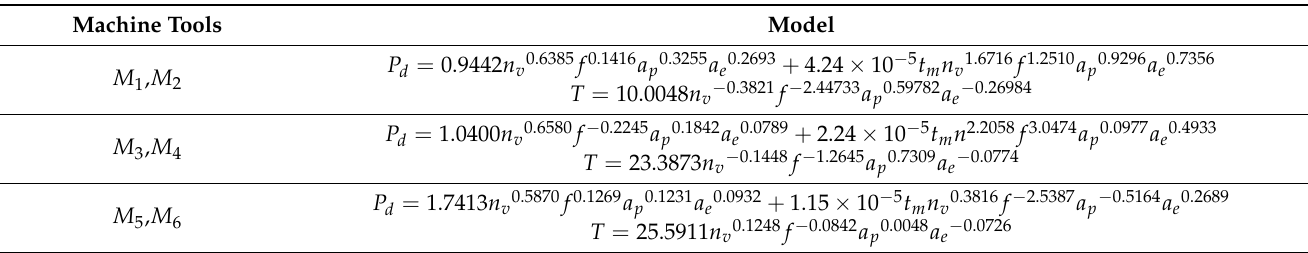
Table 4. Cutting-tool degradation model.